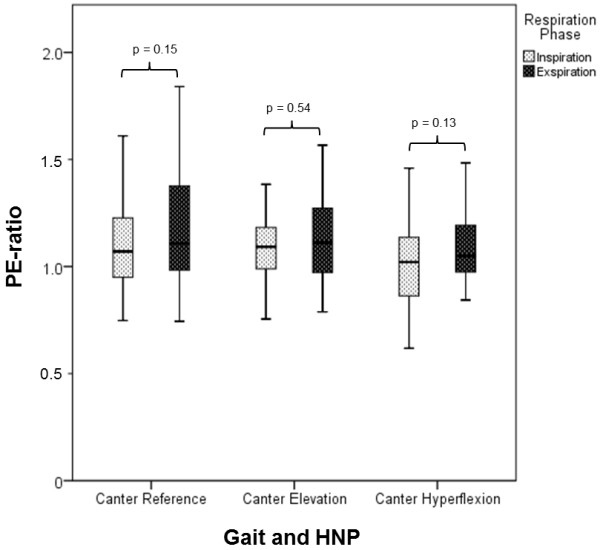
Pharynx-epiglottis-ratio as a function of the breathing cycle. There was no significant difference in the PE-ratio dependent on the respiratory phase in any of the examined head and neck position at canter (n = 10).